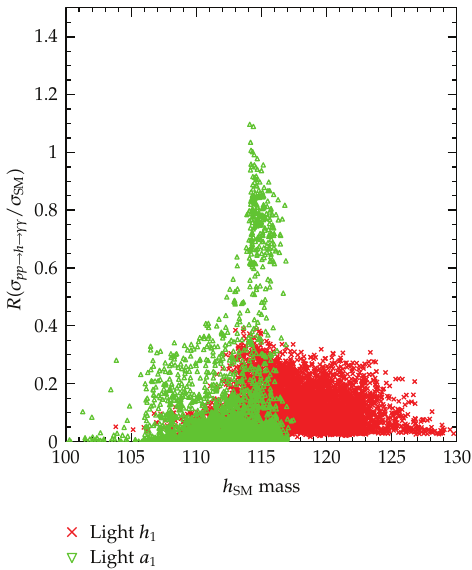
Figure 8: Same as Figure 6, but showing the diphoton production rate of the SM-like Higgs boson at the